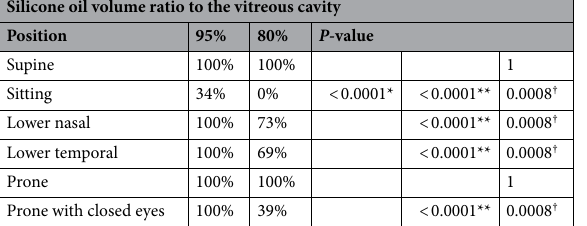
Silicone oil volume ratio to the vitreous